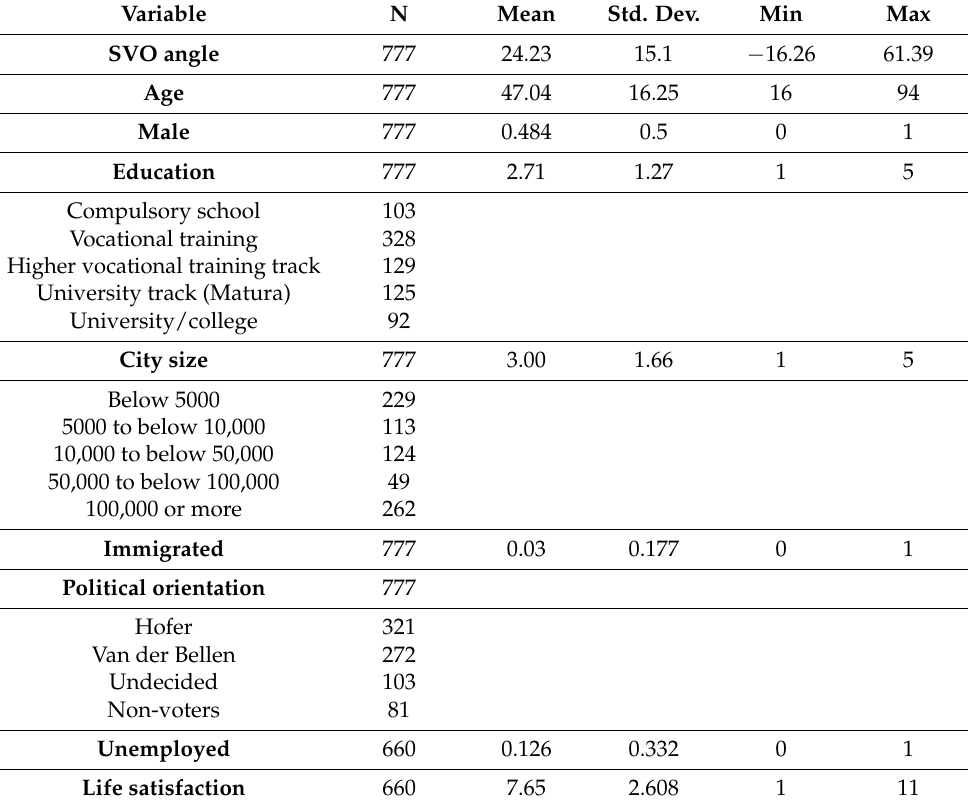
Table A1. Description of the sample.